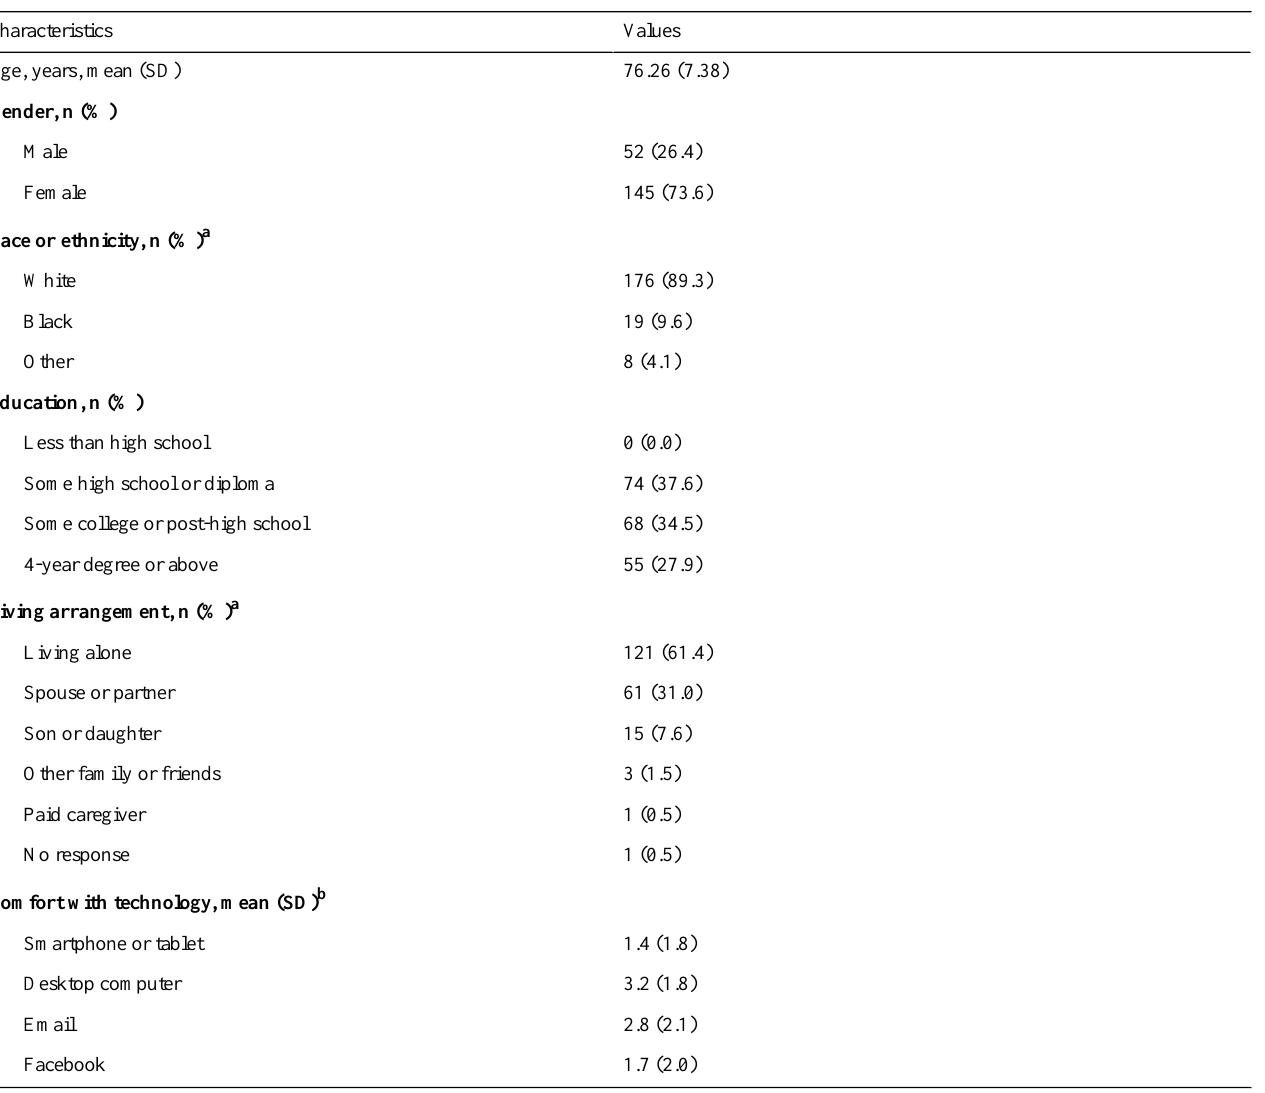
Table 1. Descriptive characteristics of participants at baseline (N=197).